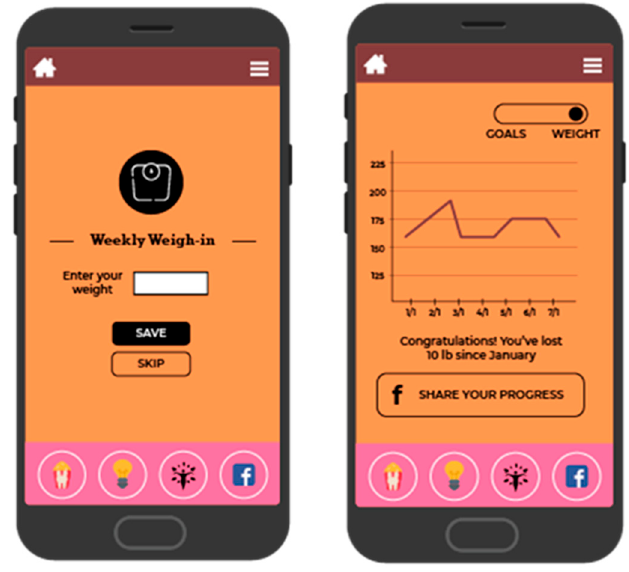
Figure 2. Screenshot of weight tracking and feedback.